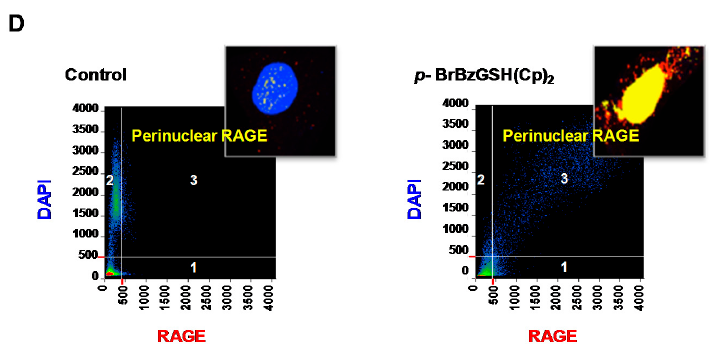
Figure 4. GLO1 inhibition induced RAGE expression and increased DNA-AGEs in GBM cells. ( A ) MS/MS quantification of ( R , S ) CEdG in T98 and U87 GBM cell lines before ( − ) and after (+) p- BrBzGSH(Cp) 2 treatment (75 and 30 µM, 24 h, respectively). Error bars indicate the mean ± SEM. Data are representative of at least three independent determinations. ( B ) Expression levels of GLO1 and RAGE mRNA in T98 and U98 cells before ( − ) and after (+) p- BrBzGSH(Cp) 2 treatment (75 and 30 µM, 24 h, respectively). Data represent the mean of at least three independent determinations by RT-qPCR and normalized to β -actin; ( C ) Quantification of RAGE protein in T98 and U87 GBM cells by immunocytochemical staining following 24 h treatment with p -BrBzGSH(Cp) 2 , n ≥ 50 cells evaluated per condition. IOD = integrated optical density. **** p <0.0001, ** p < 0.01, * p < 0.05, ns = not significant, by two-way analysis of variance (ANOVA). P values were determined using Tukey’s method when correcting for multiple comparisons; ( D ) Representative images for colocalization studies in control and GLO1 inhibitor treated T98 and U87 cells revealed intracellular distribution of RAGE: Gate 1, cytoplasmic RAGE (red); Gate 2, nuclei only (blue); Gate 3, perinuclear RAGE. T98 control cells and inset shows cytoplasmic RAGE distribution (red) and scattered perinuclear staining (yellow) for RAGE. T98 cells treated with p- BrBzGSH(Cp) 2 displayed enhanced perinuclear RAGE and inset shows intense RAGE staining (yellow) within the perinuclear region.